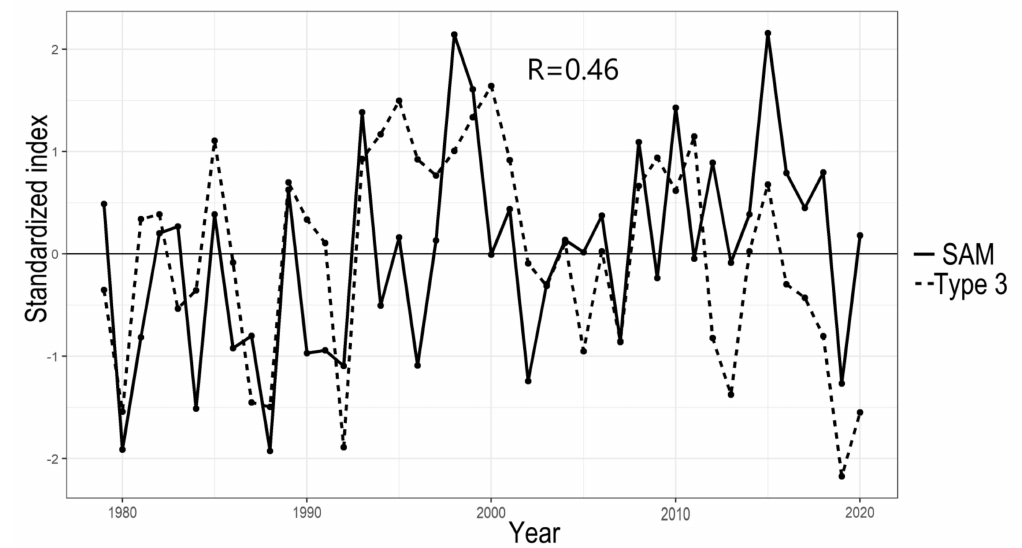
Figure 8. Time series of the SAM and Type 3 for the 1979–2020 period. The correlation coefficient between the indices is written in the graph.